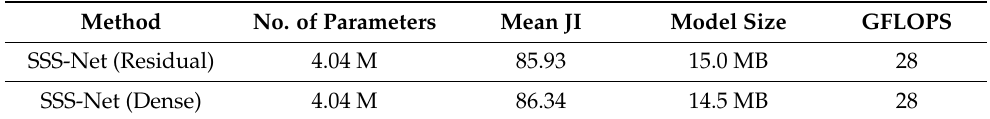
Table 1. Ablation study of proposed